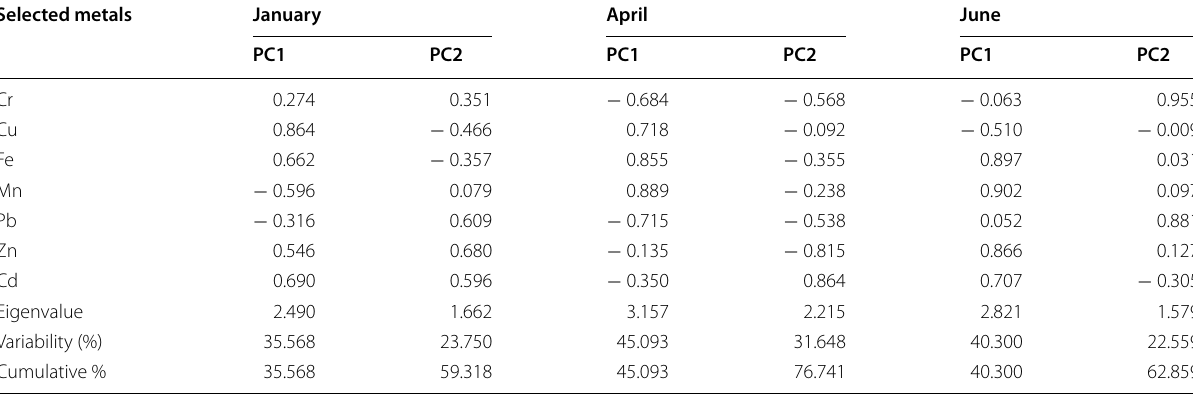
Table 3 Factor loadings of selected heavy metals in the borehole water samples during the monitoring period Selected